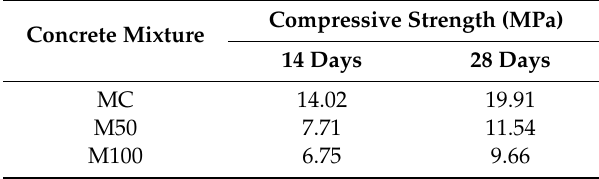
Table 4. Compressive strength at 14 and 28 days ( f (cid:48) c in